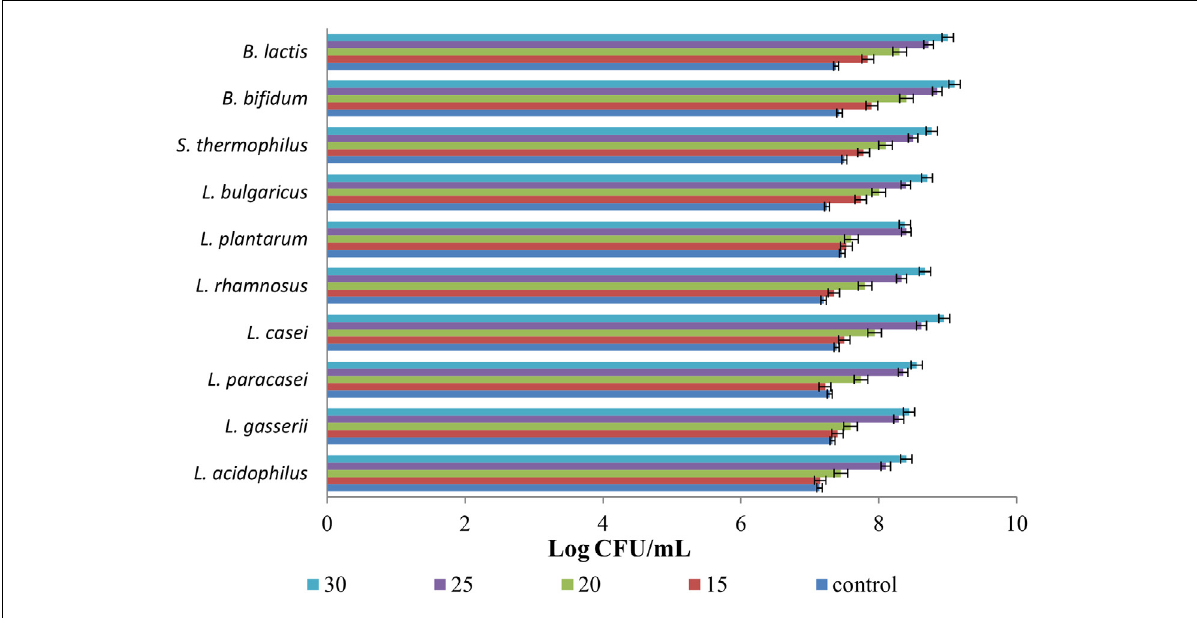
The influence of crude fucoxanthin (µg/mL medium) on probiotics and starter culture viability. Data are expressed as a mean of three replicates ±